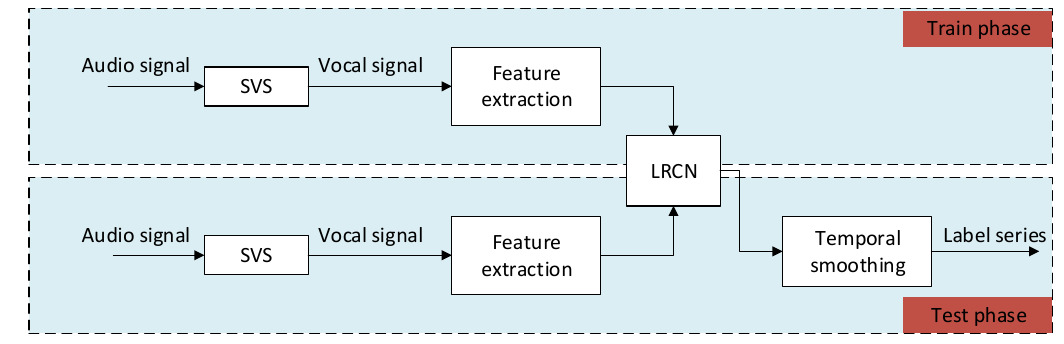
Figure 1. Overview of the proposed singing voice detection